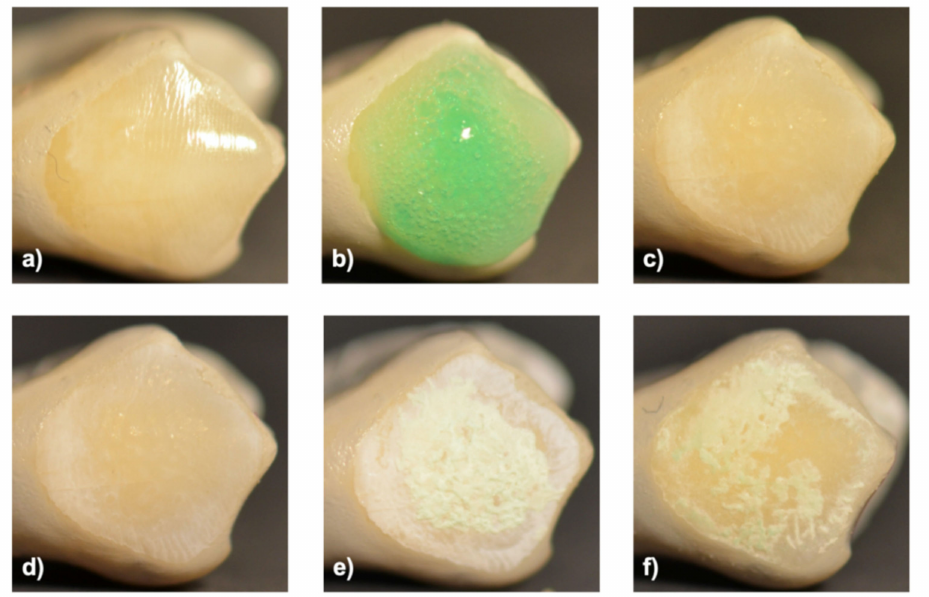
Figure 1. ( a ) The initial aspect of a tooth. ( b ) Hydrochloric acid in action. ( c ) After 30 min of demineralization. ( d ) After 1 h of demineralization. ( e ) After 24 h of demineralization. ( f ) After 96 h of